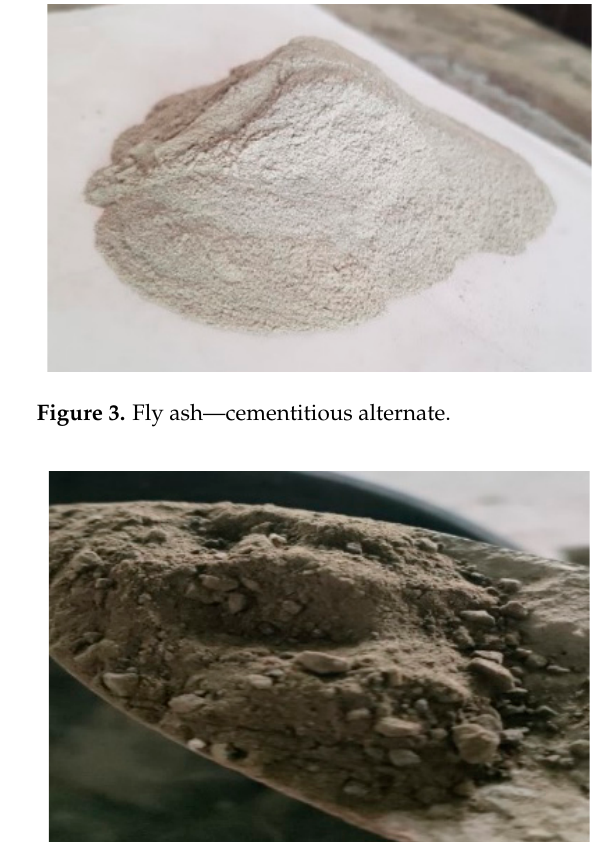
Figure 2. Co- fi red ash—Agro-industrial waste.